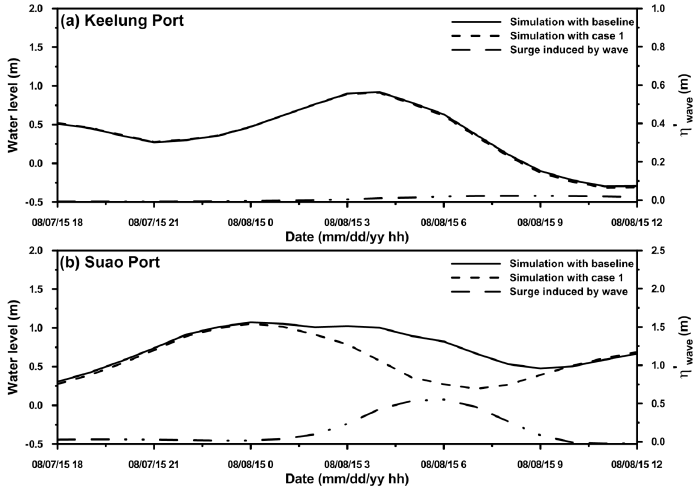
Table 3. Designed numerical experiments for investigating the factors contributing to